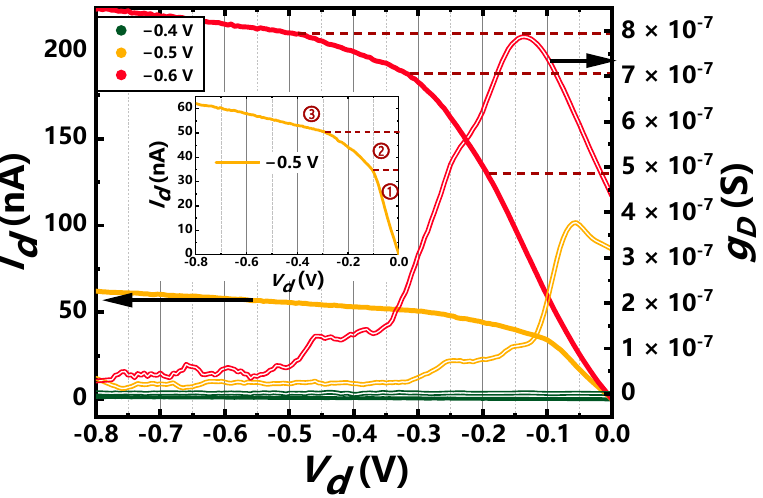
Figure 6. Measured I d – V d curves and channel conductance g D for different gate voltages at 6 K. Inset: the I d – V d characteristics at V g = − 0.5 V.